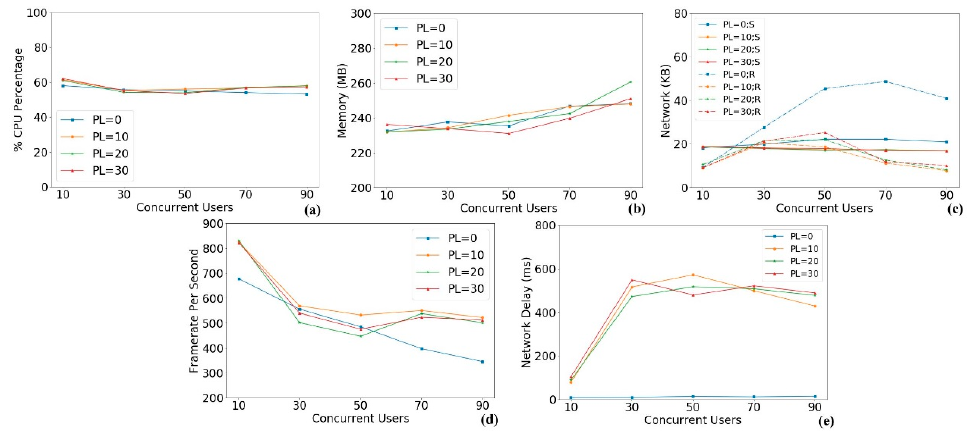
Figure 10. PC resource consumption in different number of concurrent users and different packet lags: ( a ) CPU percentage; ( b ) memory; ( c ) network; ( d ) framerate per second; ( e ) network delay. • VR side